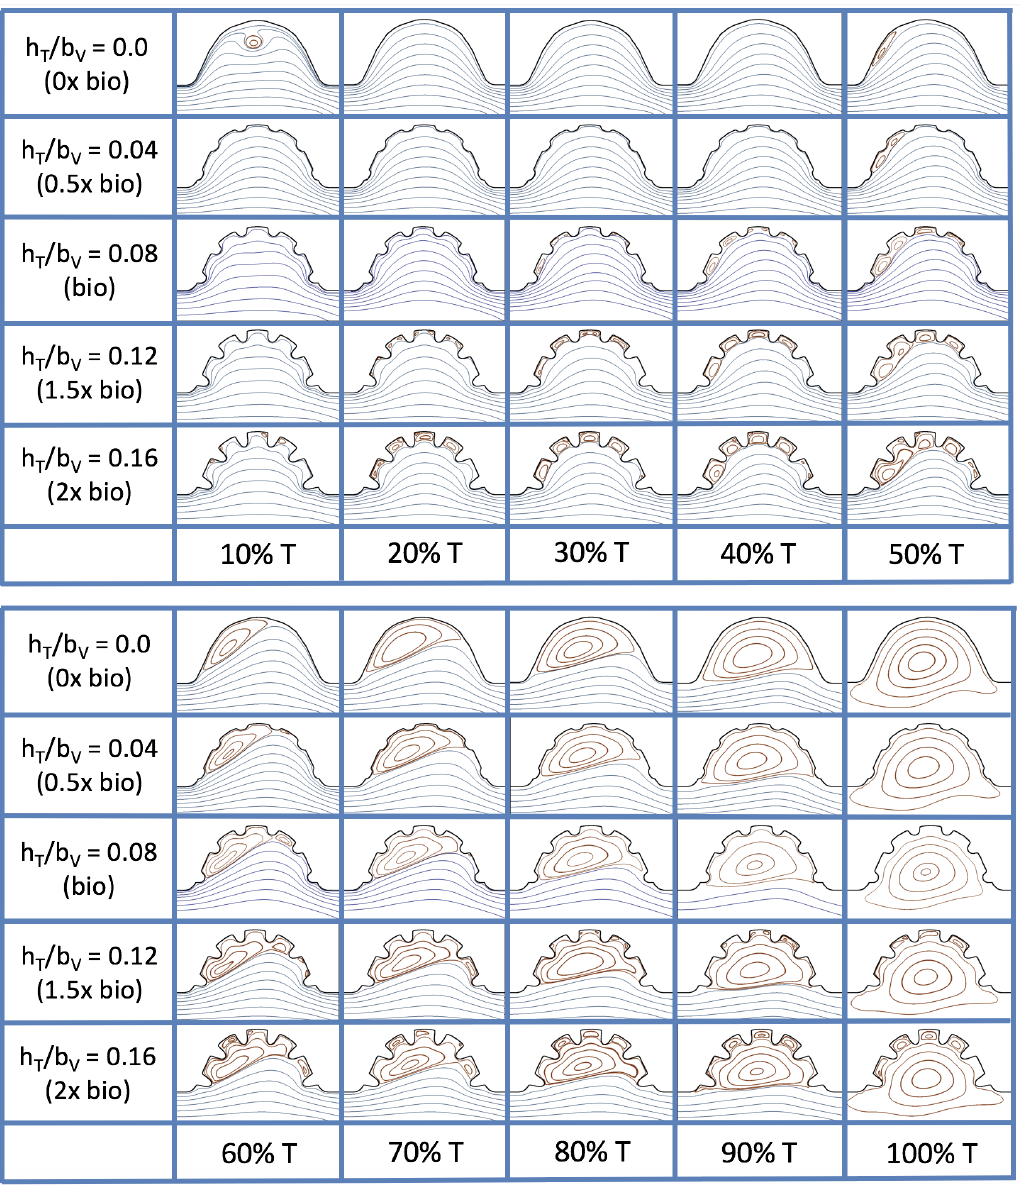
Figure 23. Streamline analysis taken at different time points within a single pulsation cycle (described by a percentage of a single pulsation period, T ) for the case of pulsatile flow into the idealized trabeculated ventricle of a zebrafish at 4 dpf for Re = 10.0 and varying trabeculae heights. The spin direction is determined from the laminar flow, given in blue, moving left to right. When vortices first form in the intertrabecular regions, the vortices form moving counterclockwise. counterclockwise, which forces any intertrabecular vortices that form to move